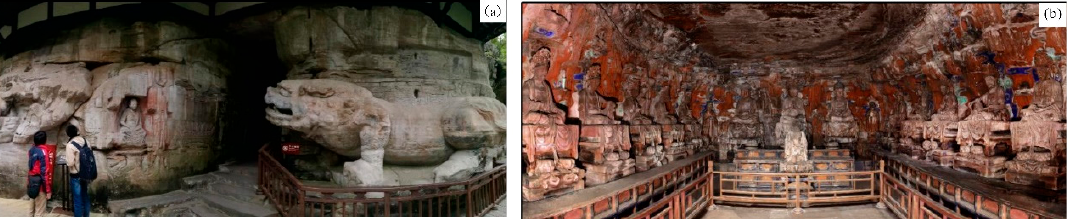
Figure 1. Yuanjue Cave Cultural Relics Protection Zone ( a ) outside the cave and ( b ) inside the cave.